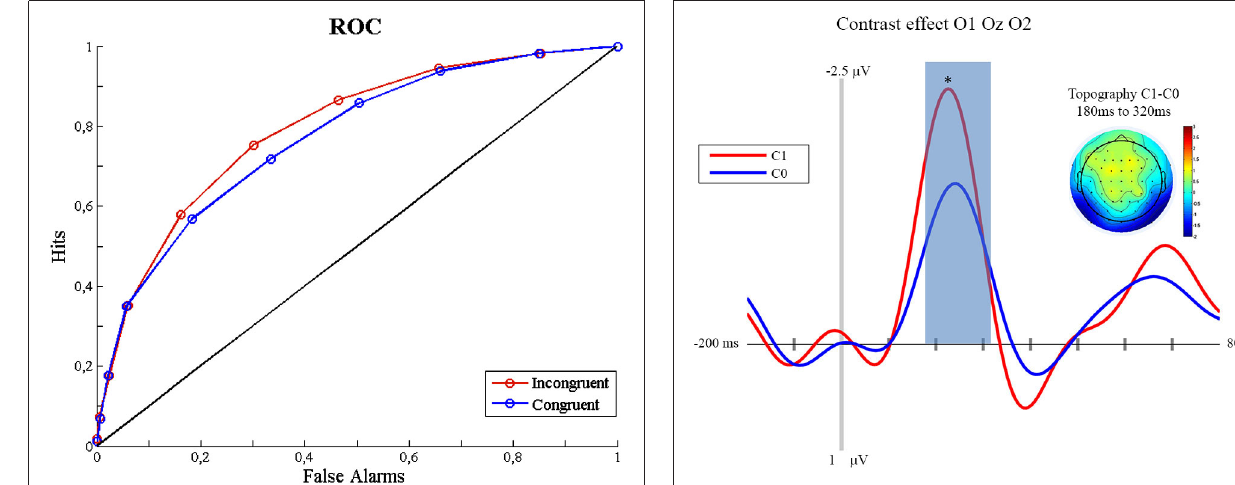
FIGURE 1 | ROC curves . Mean of participants ROC curves for congruent and incongruent trials. For calculation detail of the ROC see Analysis of Discrimination Performance section.